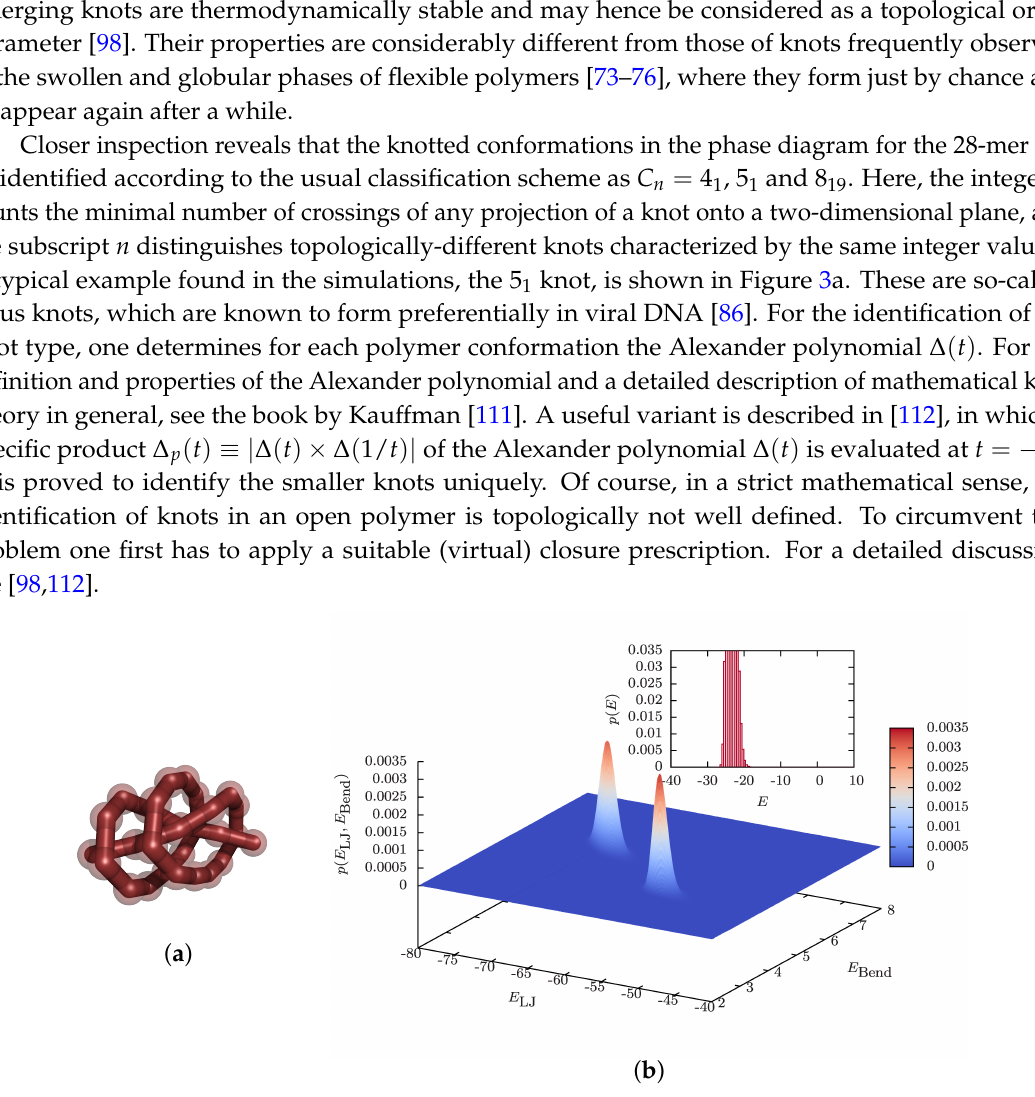
Figure 3. Characterization of the transition into polymer knots for a semiflexible bead-stick polymer ( N = 28) adapted from [98]. ( a ) Typical knot of type 5 1 (at κ = 7.50, T = 0.045). ( b ) Two-dimensional (potential) energy histogram p ( E LJ , E Bend ) at the D3–K5 1 transition for κ = 8.0 at T = 0.18, signaling clear phase coexistence. The inset shows the one-dimensional histogram p ( E ) of the total (potential) energy E = E LJ + κ E Bend , which corresponds to a projection along the diagonal of the two-dimensional histogram. In this projection, the two peaks fall on top of each other, so only a single peak is visible in p ( E )